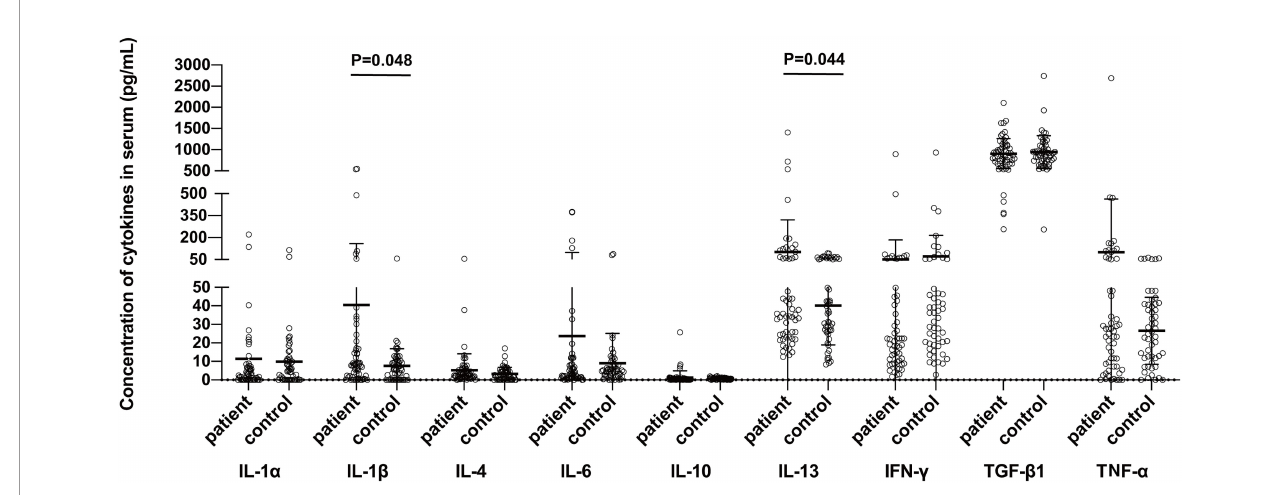
FIGURE 1 | Comparison of serum cytokine levels between bullous pemphigoid patients and control groups. The protein concentrations were measured in the BP patients and healthy control subjects using the commercially available ELISA kits. Statistical analysis revealed a signi fi cant difference in the concentrations of IL-1 b (P=0.048) and IL-13 (P=0.044) between the patient and control groups,